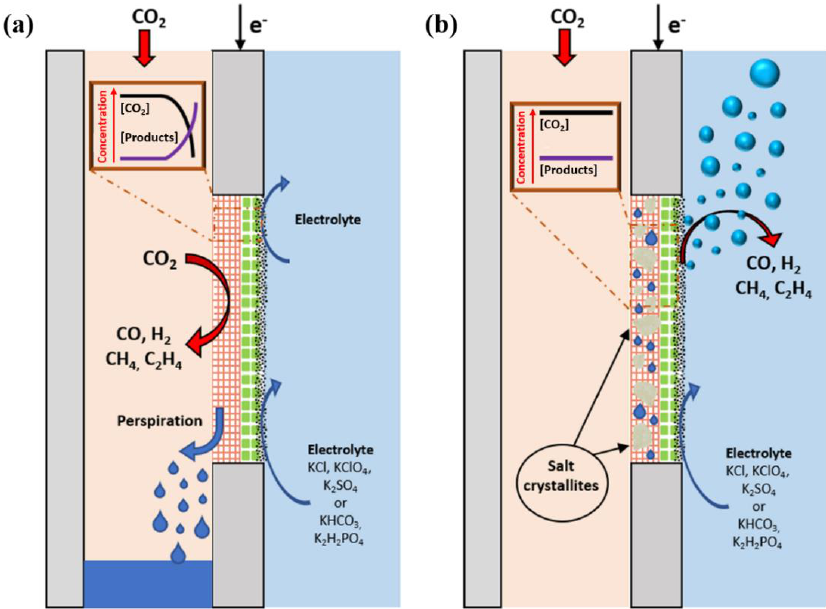
Figure 6. Schematics of the principle of operation of flow-by and flow-through configurations. ( a ) In flow-by mode, CO 2 gas enters the GDE without crossing it entirely. CO 2 and gas products concentration gradients are established along the depth of the GDE. Gas products (CO, H 2 , CH 4 , C 2 H 4 , etc.) join the CO 2 gas stream at the back of the GDE. Catholyte perspiration is also shown. ( b ) In flow-through mode, CO 2 gas enters and cross the GDE to emerge as bubbles in the catholyte. No concentration gradients of CO 2 and gas products are present in the GDE. Electrolyte crystallisation in the GDE is also shown.